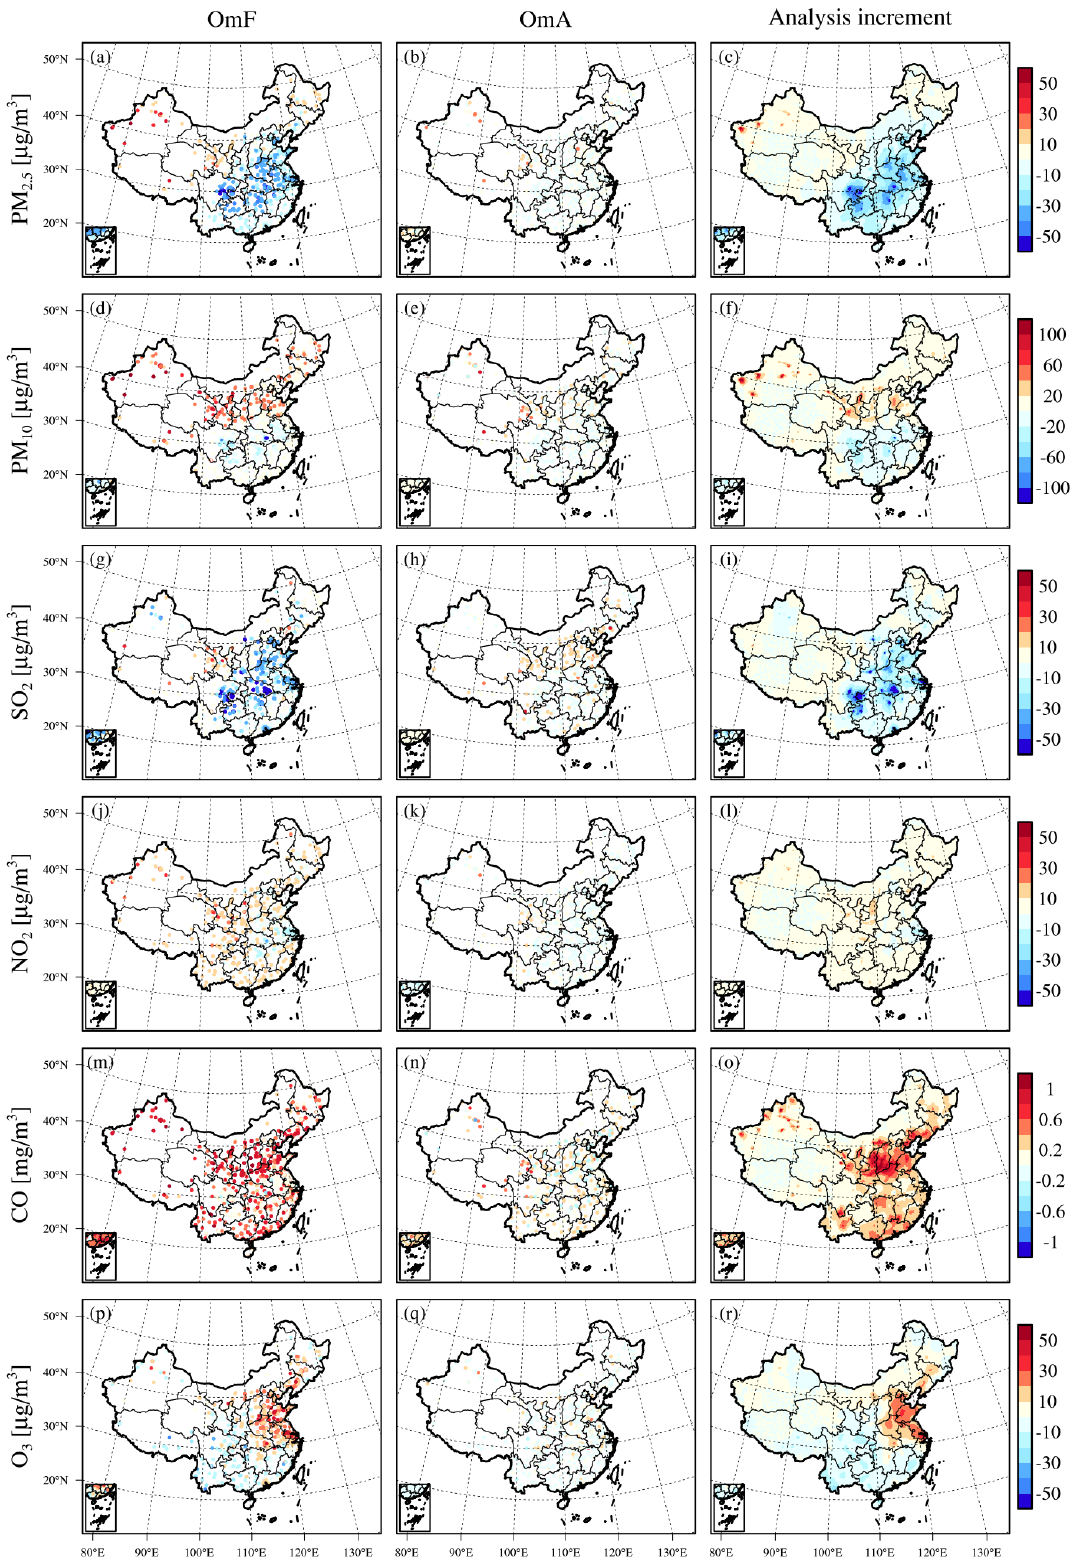
Figure 4. Spatial distributions of the 6-year mean OmF (left column), OmA (middle column), and analysis increment (right column) for different species in